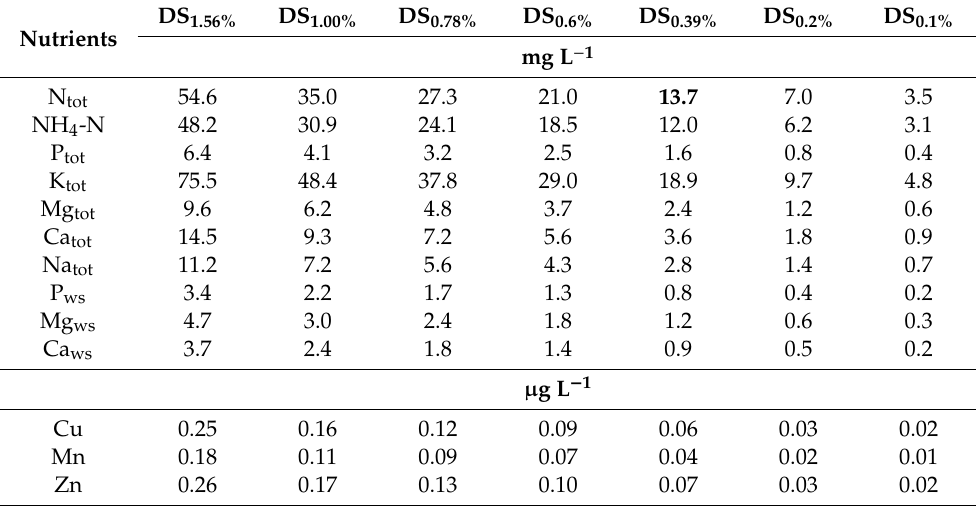
Table 2. Initial nutrient concentrations in growth media with di ff erent concentrations of the digestate from the biogas plant (DS).